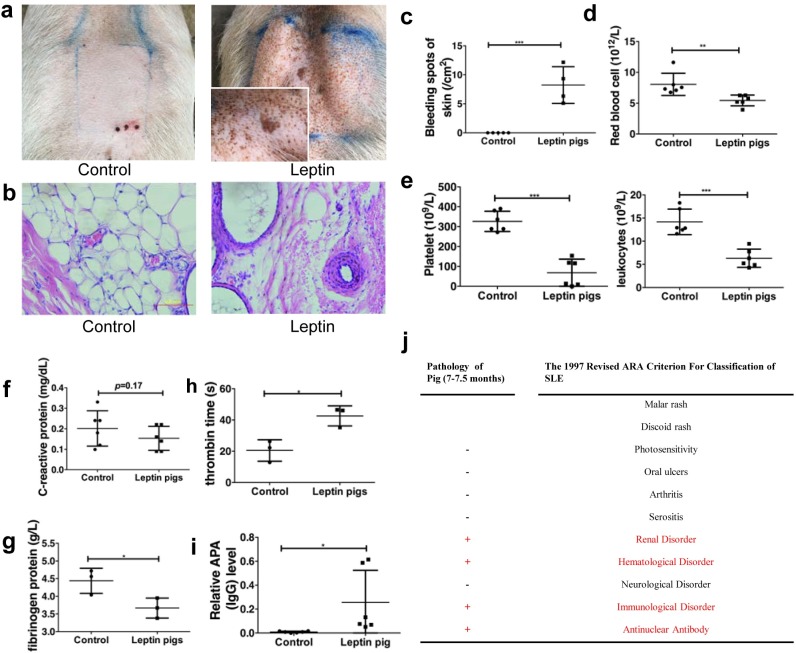
Physiological examination of leptin-overexpressing pigs.(a) Images of the backs of control and leptin-overexpressing pigs. (b) H&E staining showed RBC diffusion in the dermis of leptin-overexpressing pigs but not in the control pigs. Original magnification, 100×. (c,d) Statistical analysis of the bleeding spots and the number of RBCs (n = 5). (e) Platelet and leukocyte number (n = 6). (f) CRP level examination. (g,h) Routine examination to analyze thrombin-associated factors (n = 4). (i) APA content evaluated by ELISA (n = 6). (j) The criterion for SLE characterization. *p < 0.05, *p < 0.01, ***p < 0.001, two-tailed Student t test for c,d,e,f,g,i. Data are presented as mean ± SEM. Numerical values are provided in S1 Data. APA, antiplatelet antibody; ARA, American Rheumatism Association; CRP, C-reactive protein; H&E, hematoxylin and eosin; RBC, red blood cell; SLE, systemic lupus erythematosus.